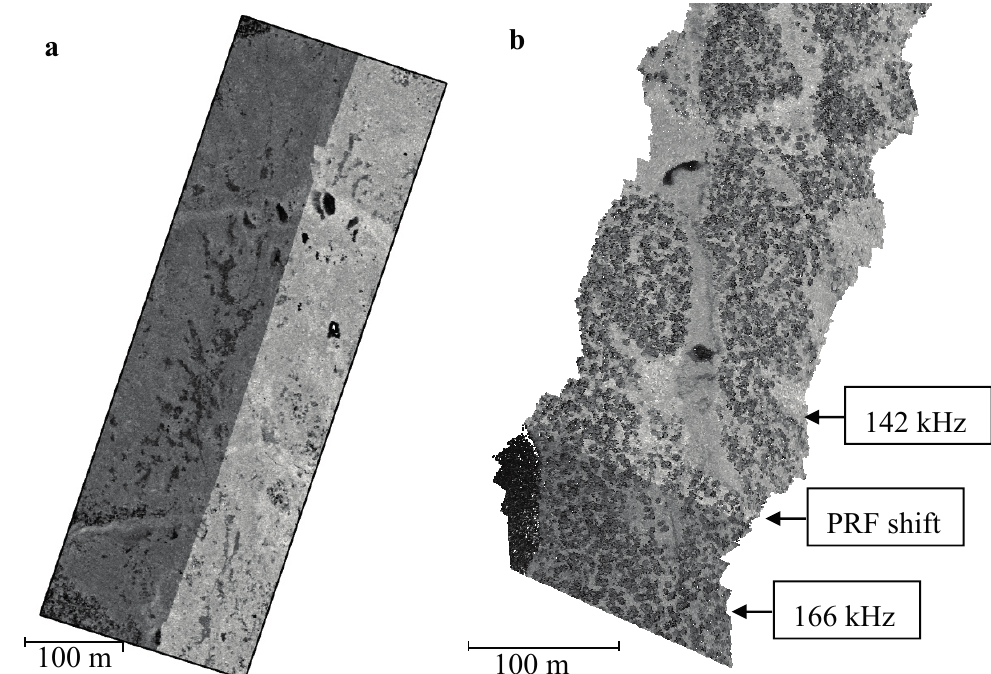
Figure 4. Illustration by backscatter intensity of the unexpected automatic shift in pulse repetition frequency (PRF) from 166 to 142 kHz for ACQ 3 . ( a ) Backscatter intensity for the two strips of ACQ 3 over the study area. Low backscatter intensity (dark grey) is shown for the western strip flown at 166 kHz, as planned. High backscatter intensity (light grey) is seen for the eastern strip (142 kHz); ( b ) Illustration of where the initial PRF (166 kHz) was restored in the eastern strip, approximately 1.2 km outside the study area, by a significant drop in backscatter